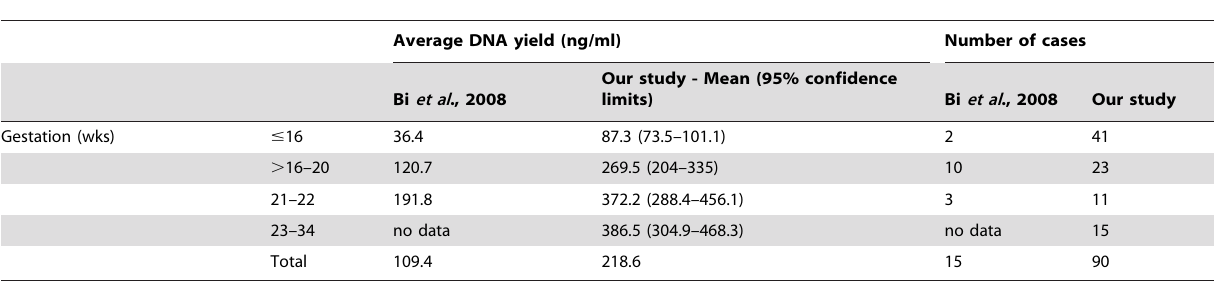
Table 4. Comparison of DNA yield and gestational age with Bi et al. [2008] study.